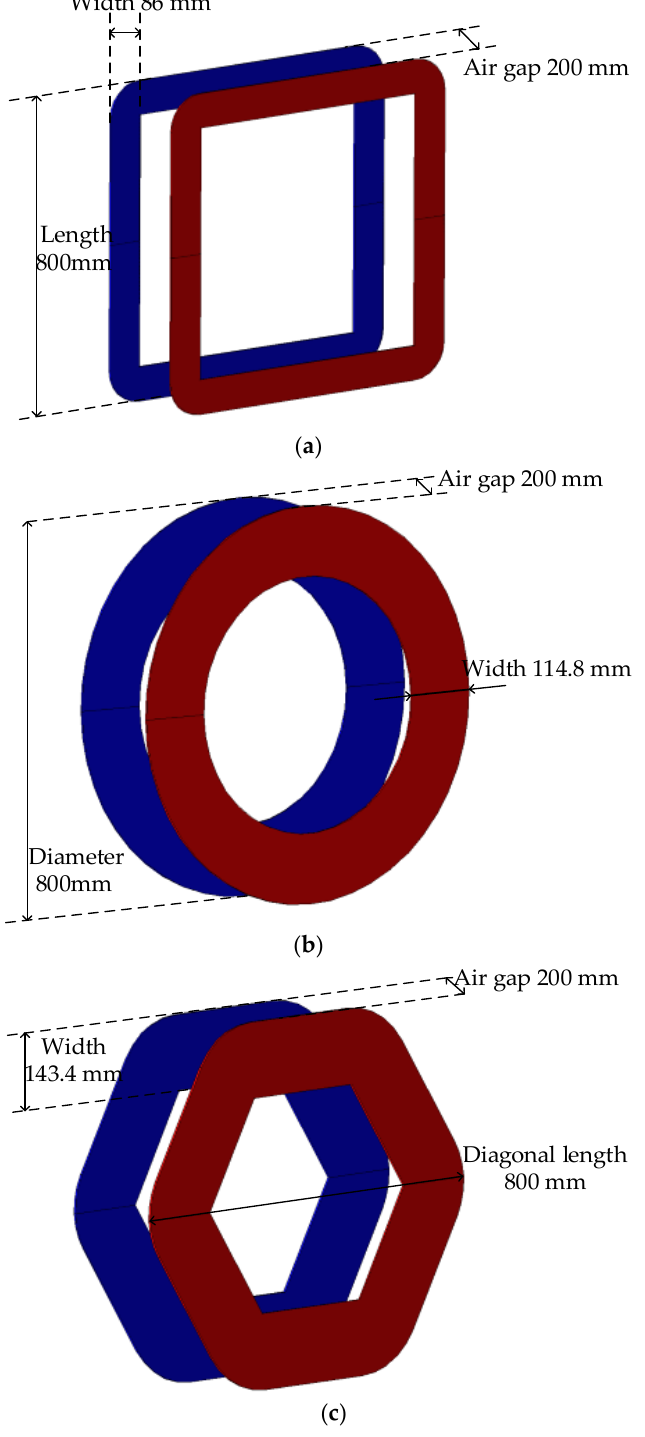
Figure 2. Three types of couplers for comparison. ( a ) Rectangular coils; ( b ) Circular coils; ( c ) Hexagonal coils.